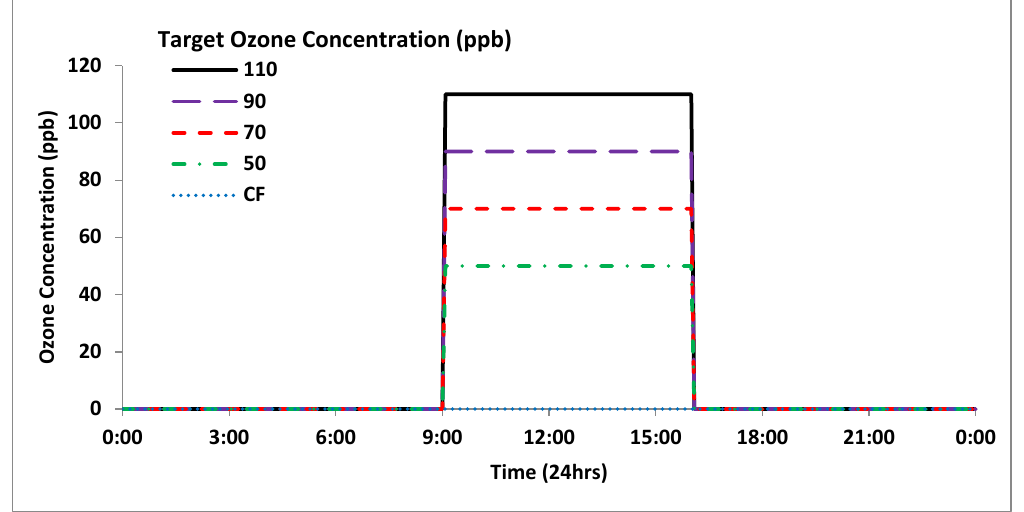
Figure 1. Steady-state O 3 treatment regime targeted in continuous stirred tank reactors (CSTRs). The actual achieved treatments were 5, 49, 70, 92, and 107 ppb, respectively.